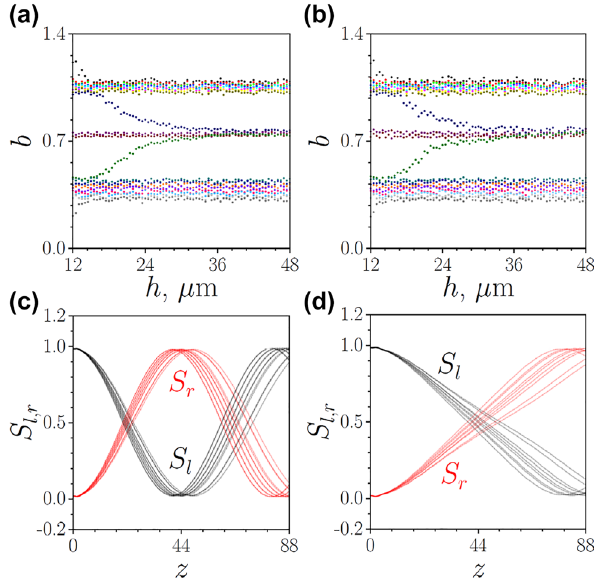
Figure 4: Eigenvalues of the modes supported by the = s = 15 μ m, d = d = 33 μ m) array as topological-topological ( s l r l r functions of spacing h between two arrays for disorder strength 𝛿 = 0.01, 𝛿 = 0.1 (a) and 𝛿 = 0.02, 𝛿 = 0.1 (b). Power sharing p s p s , and right, S , arrays as a function of propagation between left, S l r distance z at U = 0.01 (c) and U = 0.29 (d) for different realizations = 0.01, 𝛿 = 0.1 and h = 30 μ m. In all cases of disorder with 𝛿 p s p =